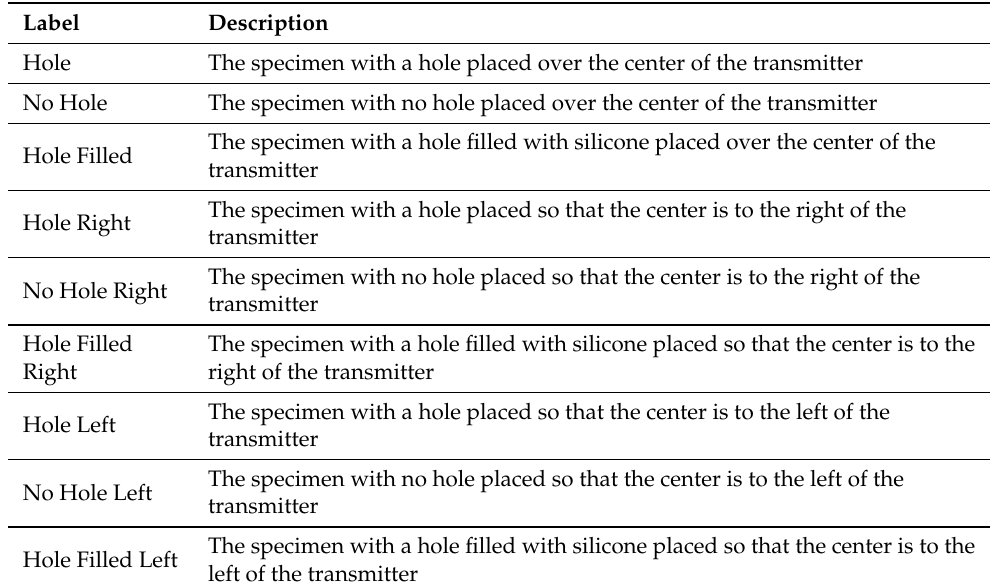
Table 1. Database Labels Used By